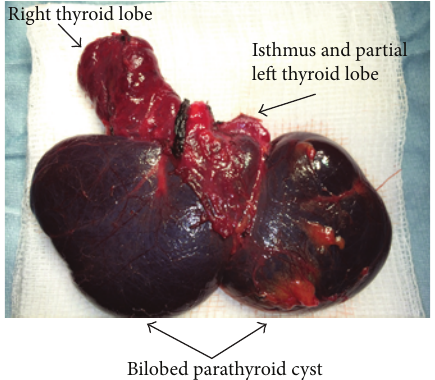
Figure 3: Parathyroid cyst intimately related to the inferior aspect of the thyroid gland, arising from the right inferior parathyroid